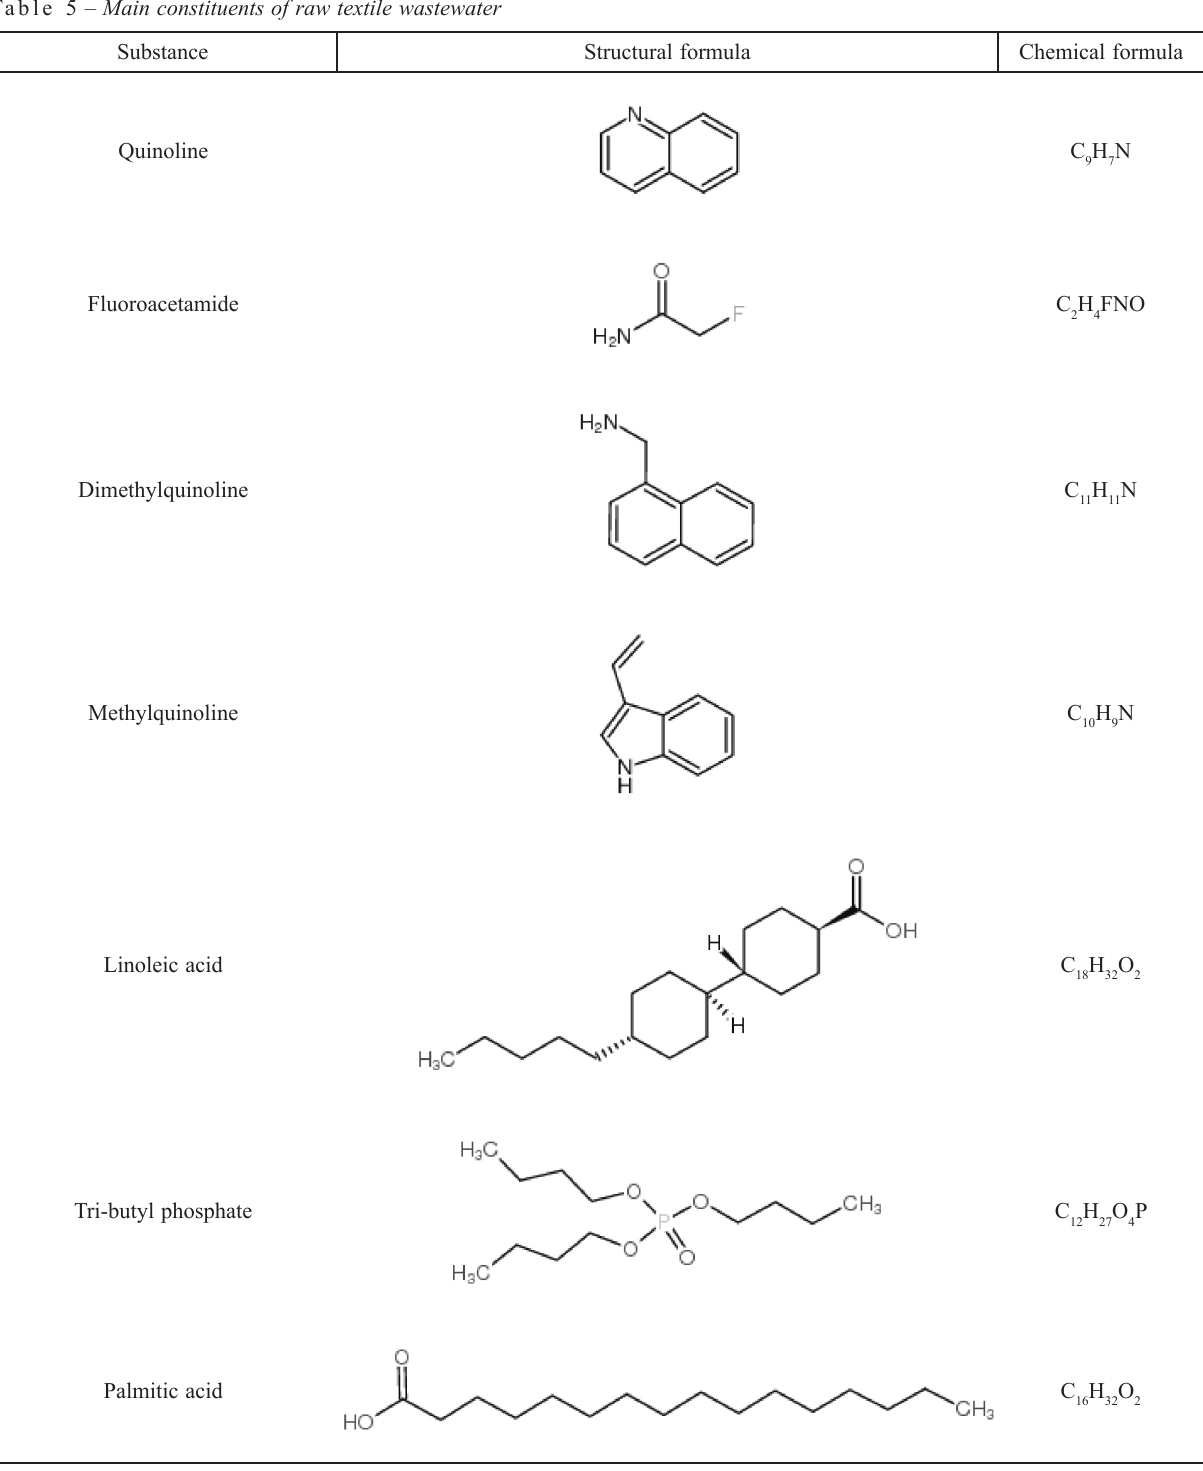
Table 5 – Main constituents of raw textile wastewater